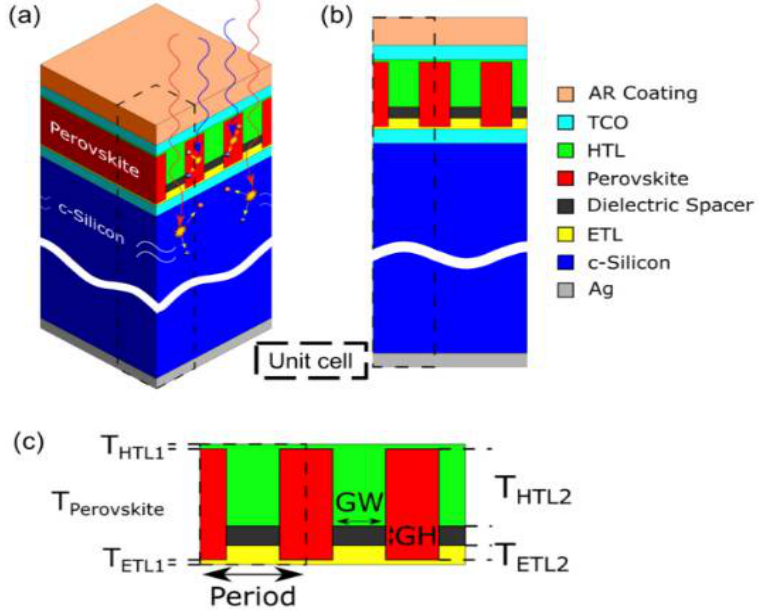
Figure 7. ( a , b ) The schematic illustration of tandem PSCs, ( c ) Details of the nanostructure [68]. Sahli et al. have directly constructed a fully textured perovskite-Si two-terminal tandem solar cell, which owns a high short-circuit current by increasing the sunlight absorption, reducing the absorption loss [69]. This structure differs from the conventional textured perovskite-Si solar cells because its structure is completely pyramid-shaped. First,